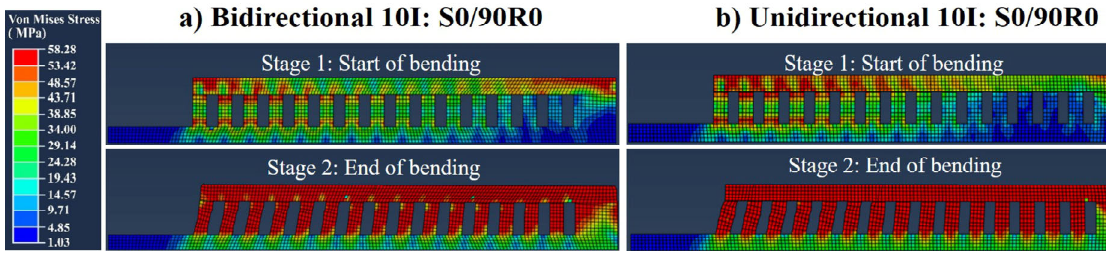
Figure 19. Simulated bending of the trusses for 10I:S0/90R0 parts: ( a ) bidirectional scanning pattern and ( b ) unidirectional scanning pattern.